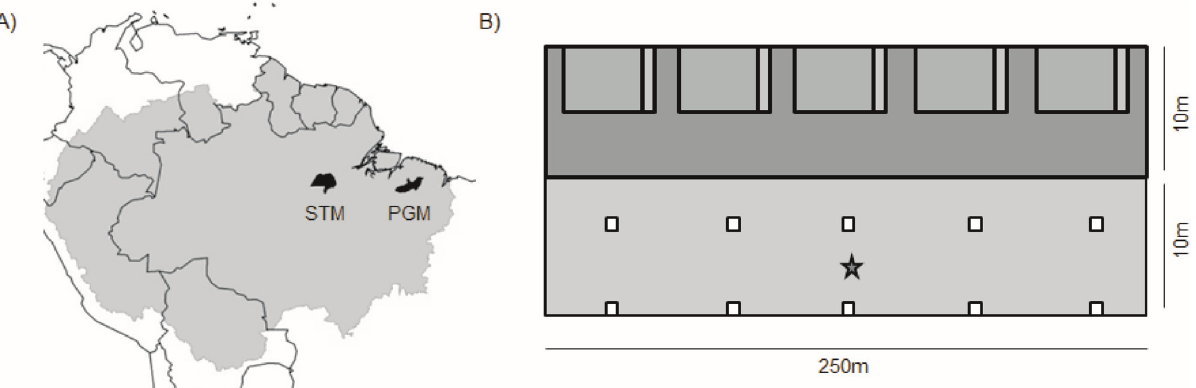
Fig 1. Sampling design. A) Location of the two study regions, Paragominas (PGM) and Santarém-Belterra (STM), within the Amazon Basin (in light gray), B) Carbon stocks assessment: Large dark gray rectangle — survey of live and dead trees and palms (cid:1) 10cm DBH and live lianas (cid:1) 10cm diameter at 1.3m from the main rooting point. Gray rectangles and small light gray rectangles attached – 5x20m subplots for identification and measurement of all live and dead trees and palms (cid:1) 2 – 9.9cm DBH and live lianas (cid:1) 2 – 9.9cm diameter at 1.3m from the main rooting point. Measurement of coarse woody debris ( (cid:1) 10cm diameter in at least one extremity) was also carried out in the 5x20m subplots. Small light gray rectangles – 2x5m subplots for fine woody debris sampling ( (cid:1) 2 – 9.9cm diameter in at least one extremity). Squares – 0.5x0.5m quadrats for leaf litter sample. Underneath the first row of litter sampling (5m away from the plot), composite soil samples were collected at three different depths: 0 – 10, 10 – 20 and 20-30cm. Star – 30x30cm trench for sampling of soil bulk density to calibrate soil carbon stocks.